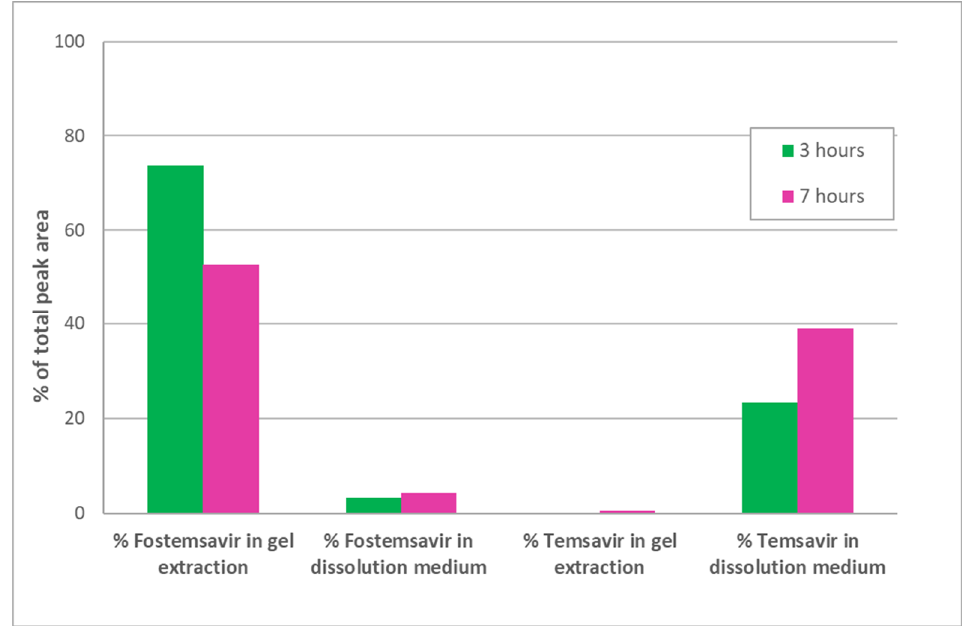
Figure 3. Concentration of fostemsavir and parent temsavir in hydrating ER tablets and dissolution media after 3 h and 7 h hydration.